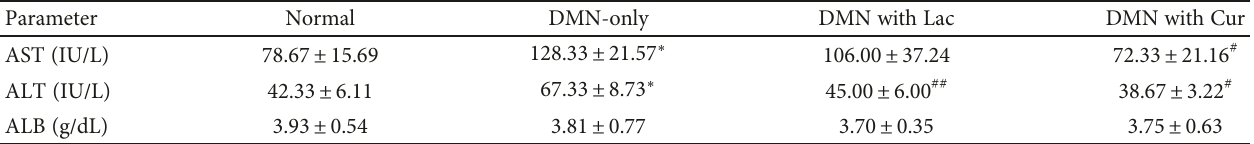
Table 2: Measurement of serum biochemical parameters in four liver tissues.